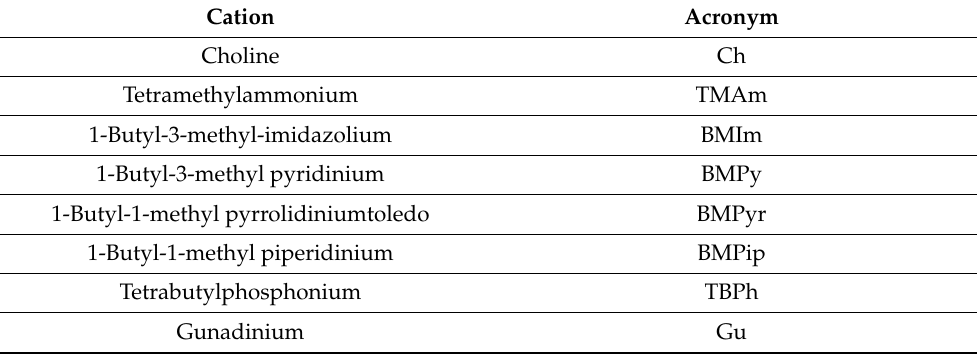
Table 1. List of the selected cations.